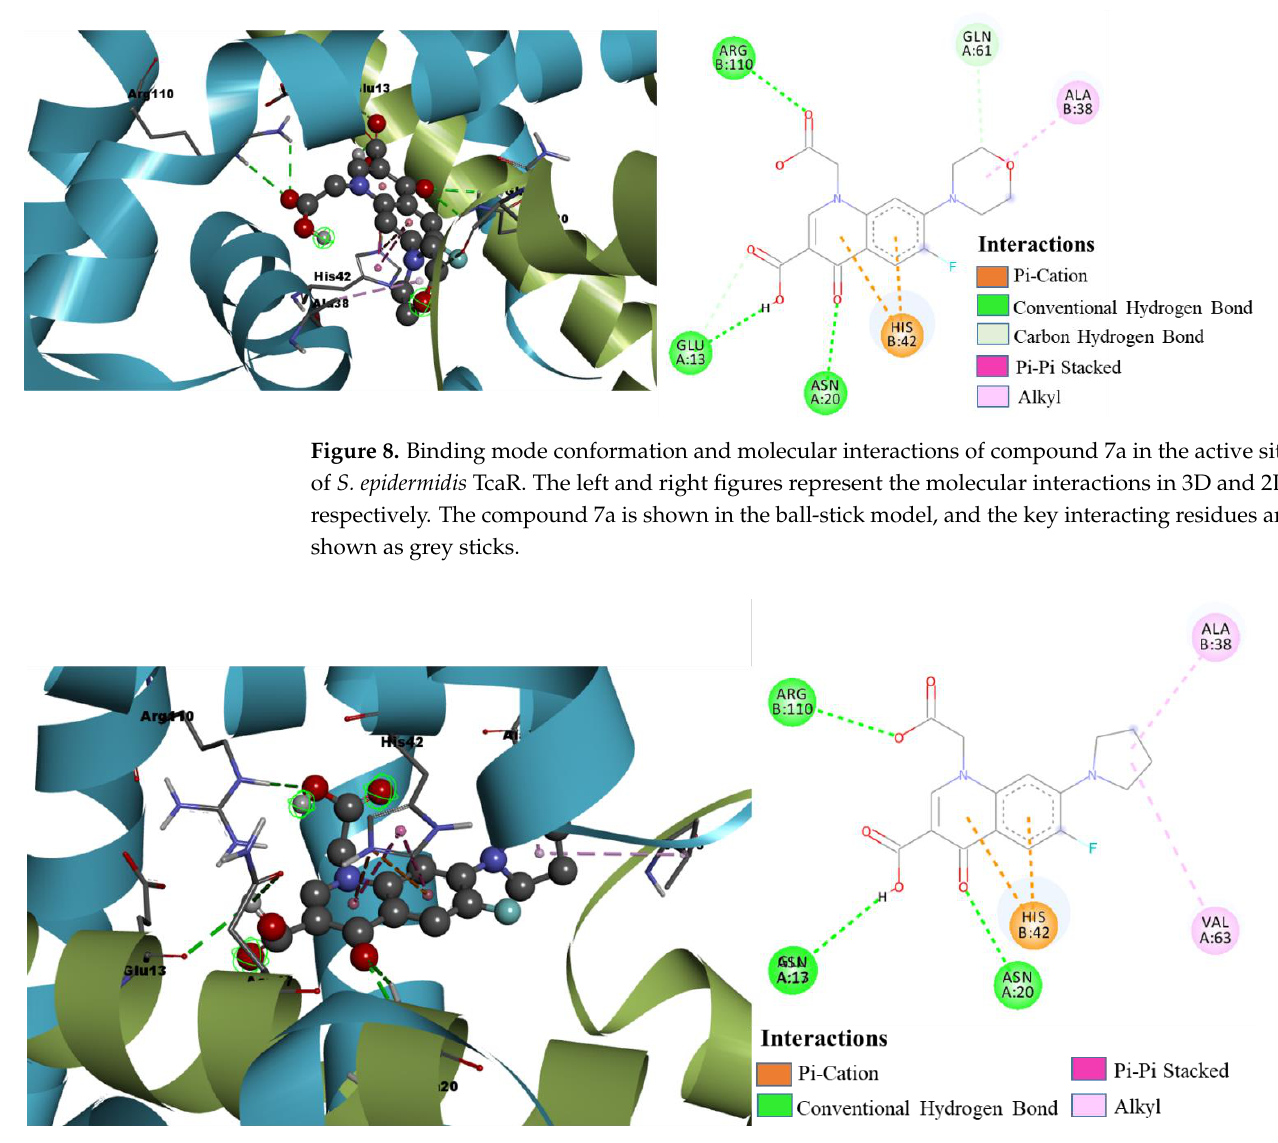
Figure 10. Binding mode conformation and molecular interactions of compound 7g in the active site of S. epidermidis TcaR. The left and right figures represent the molecular interactions in 3D and 2D, respectively. The compound 7g is shown in the ball-stick model, and the key interacting residues are shown as grey sticks. Table 2. Molecular docking results of selected dataset against S. epidermidis TcaR. Molecule